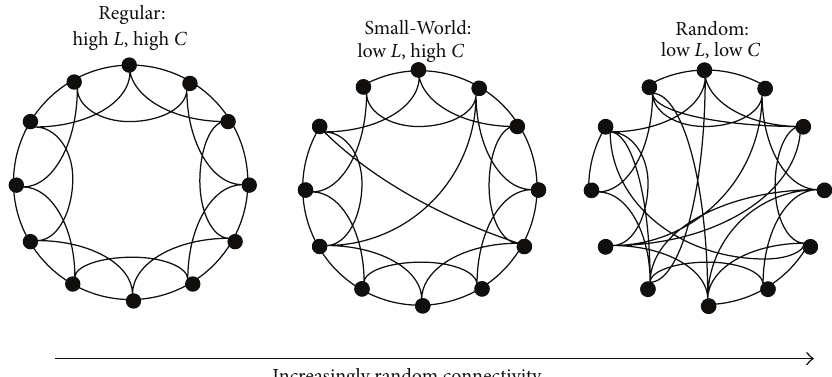
Figure 2: Classification of networks according to connectivity.